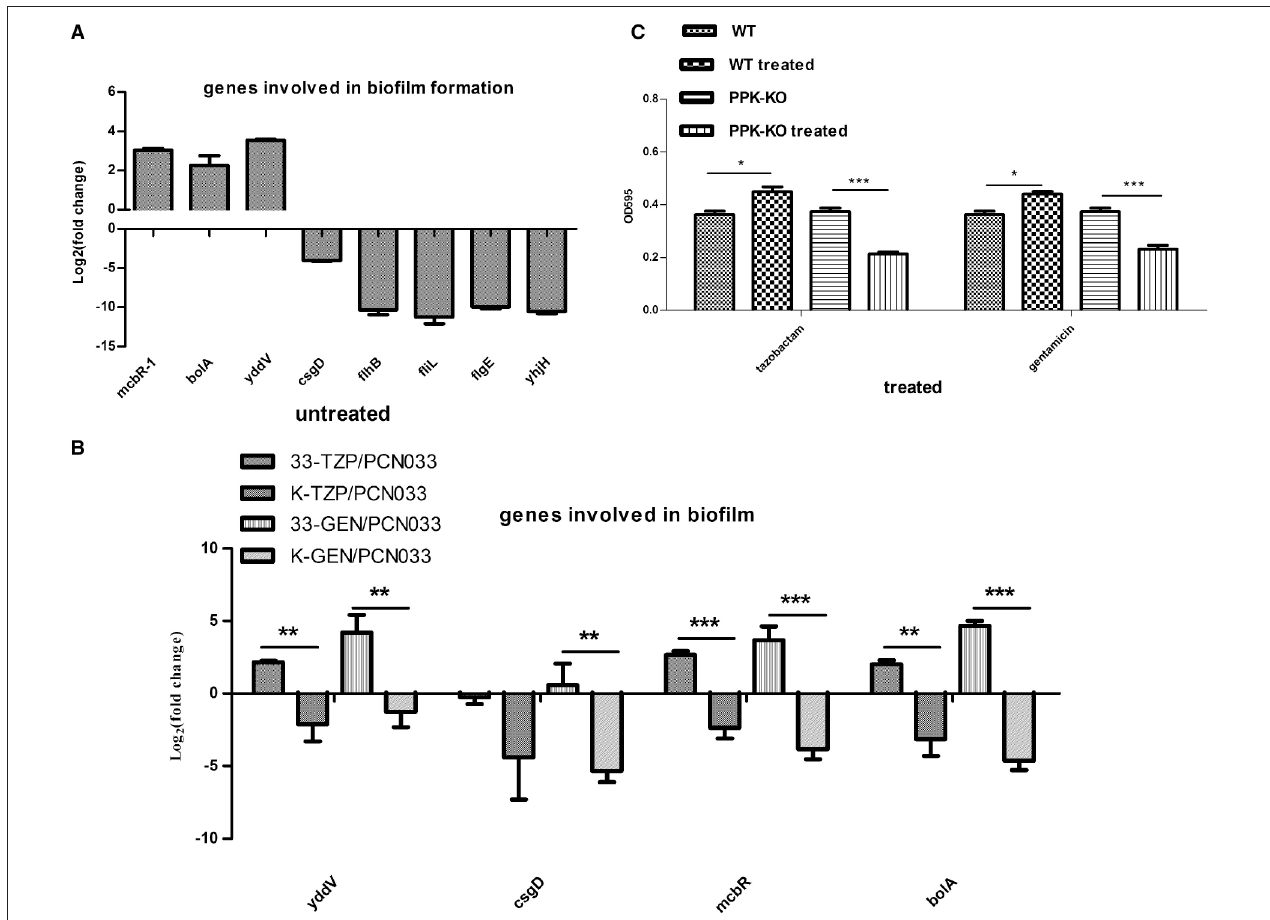
FIGURE 6 | Biofilm formation assay. (A) Validation of the expression of genes involved in biofilm formation. (B) Expression levels of genes involved in biofilm regulation during tazobactam and gentamycin treatment. (C) Biofilm formation during tazobactam or gentamycin treatment. Expression levels of genes were compared with those in WT (PCN033). 33-TZP/PCN033 indicates the expression levels in PCN033 during tazobactam treatment compared with those in untreated PCN033; K-TZP/PCN033 indicates the expression levels in the 1 ppk mutant during tazobactam treatment compared with those in untreated PCN033; 33-GEN/PCN033 indicates the expression levels in PCN033 during gentamycin treatment compared with those in untreated PCN033; K-GEN/PCN033 indicates the expression levels in the 1 ppk mutant during gentamycin treatment compared with those in untreated PCN033. WT indicates PCN033 without antibiotic treatment; WT treated indicates PCN033 with antibiotic treatment; PPK-KO indicates the 1 ppk mutant without antibiotic treatment; PPK-KO treated indicates the 1 ppk mutant with antibiotic treatment. *** p < 0.000, ** p < 0.01, * p <